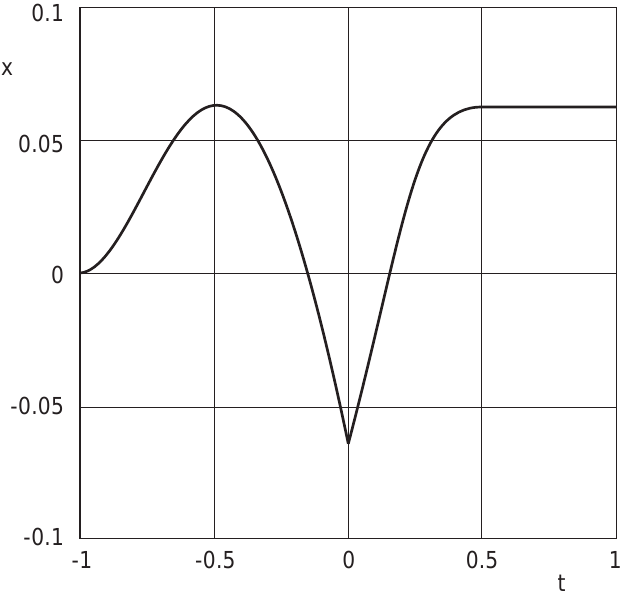
Fig. 4. Time history of the relative displacement of the object corresponding to the optimal pre-acting